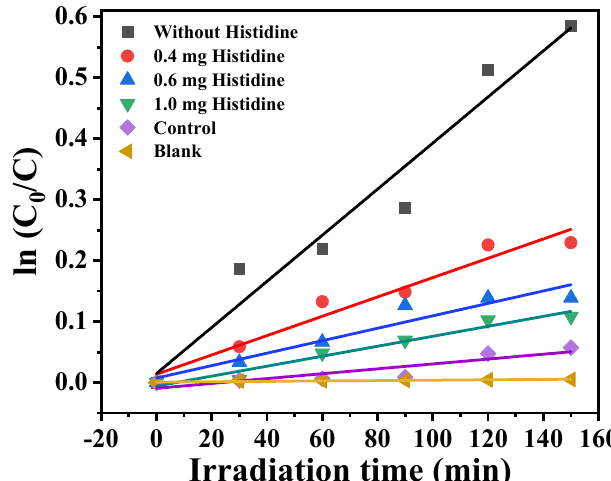
Fig. 8. Degradation kinetics of β-naphthol treated with 0.2 mg/mL of Mg OH) /CdSheteronanostructures in presence of ROS scaven- 2 ger histidine, confirmed the role of ROS toward β-naphthol degradation